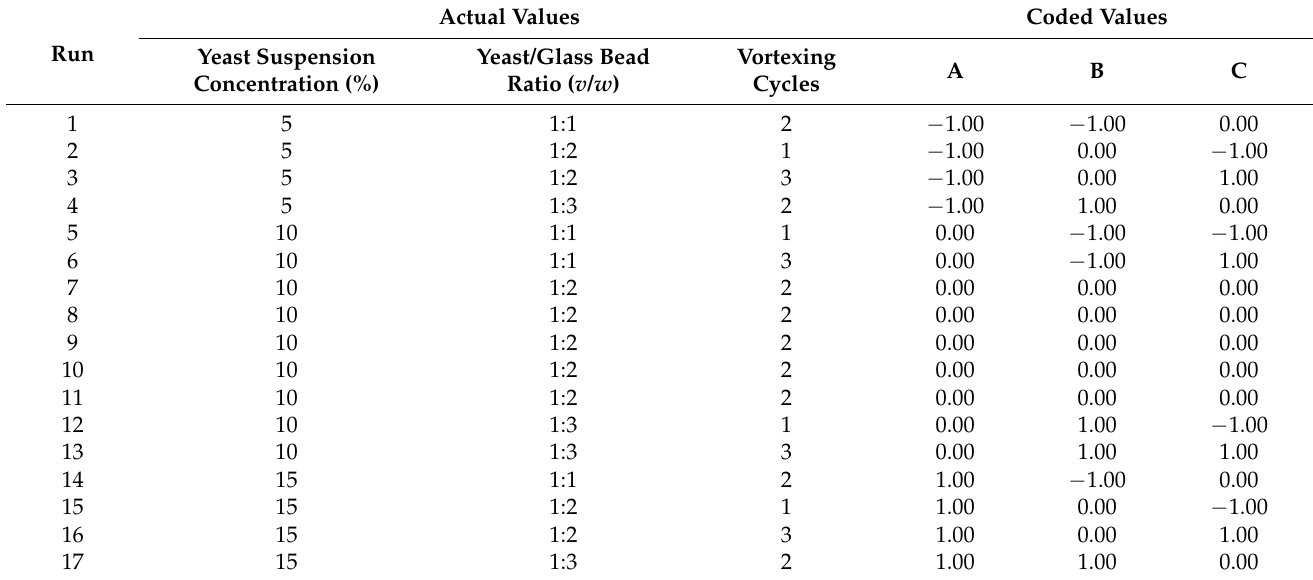
Table 1. Actual vs. coded values of the factors.